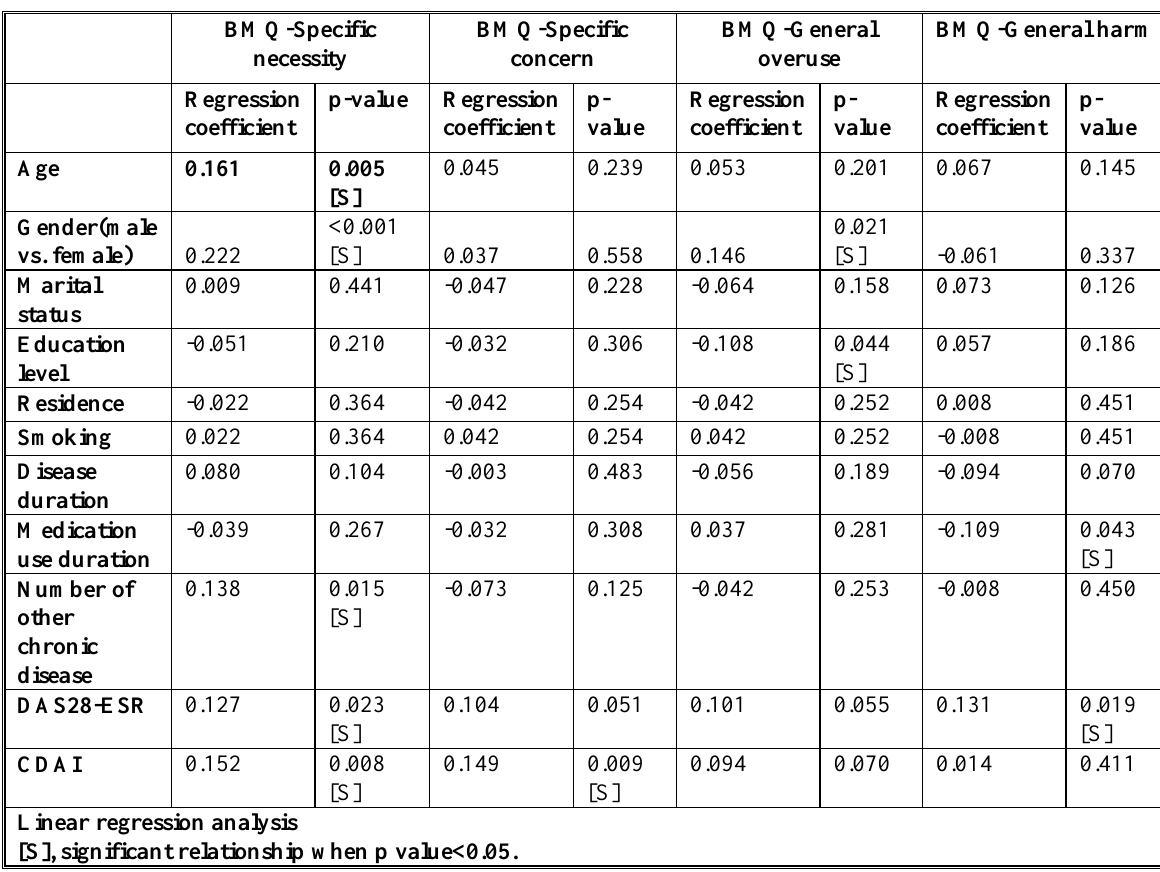
Table 5.Univariate correlation between BMQ components with various